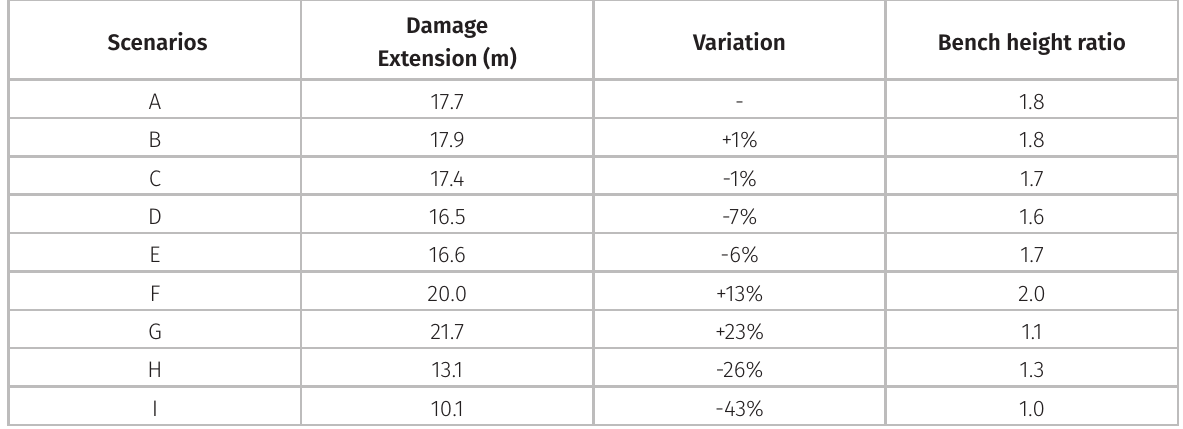
Table VII. Comparison between the expected damage extensions for the different scenarios.